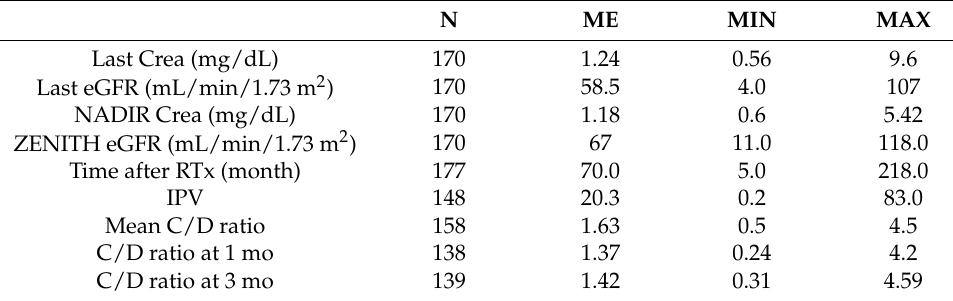
Table 1. Clinical characteristics of